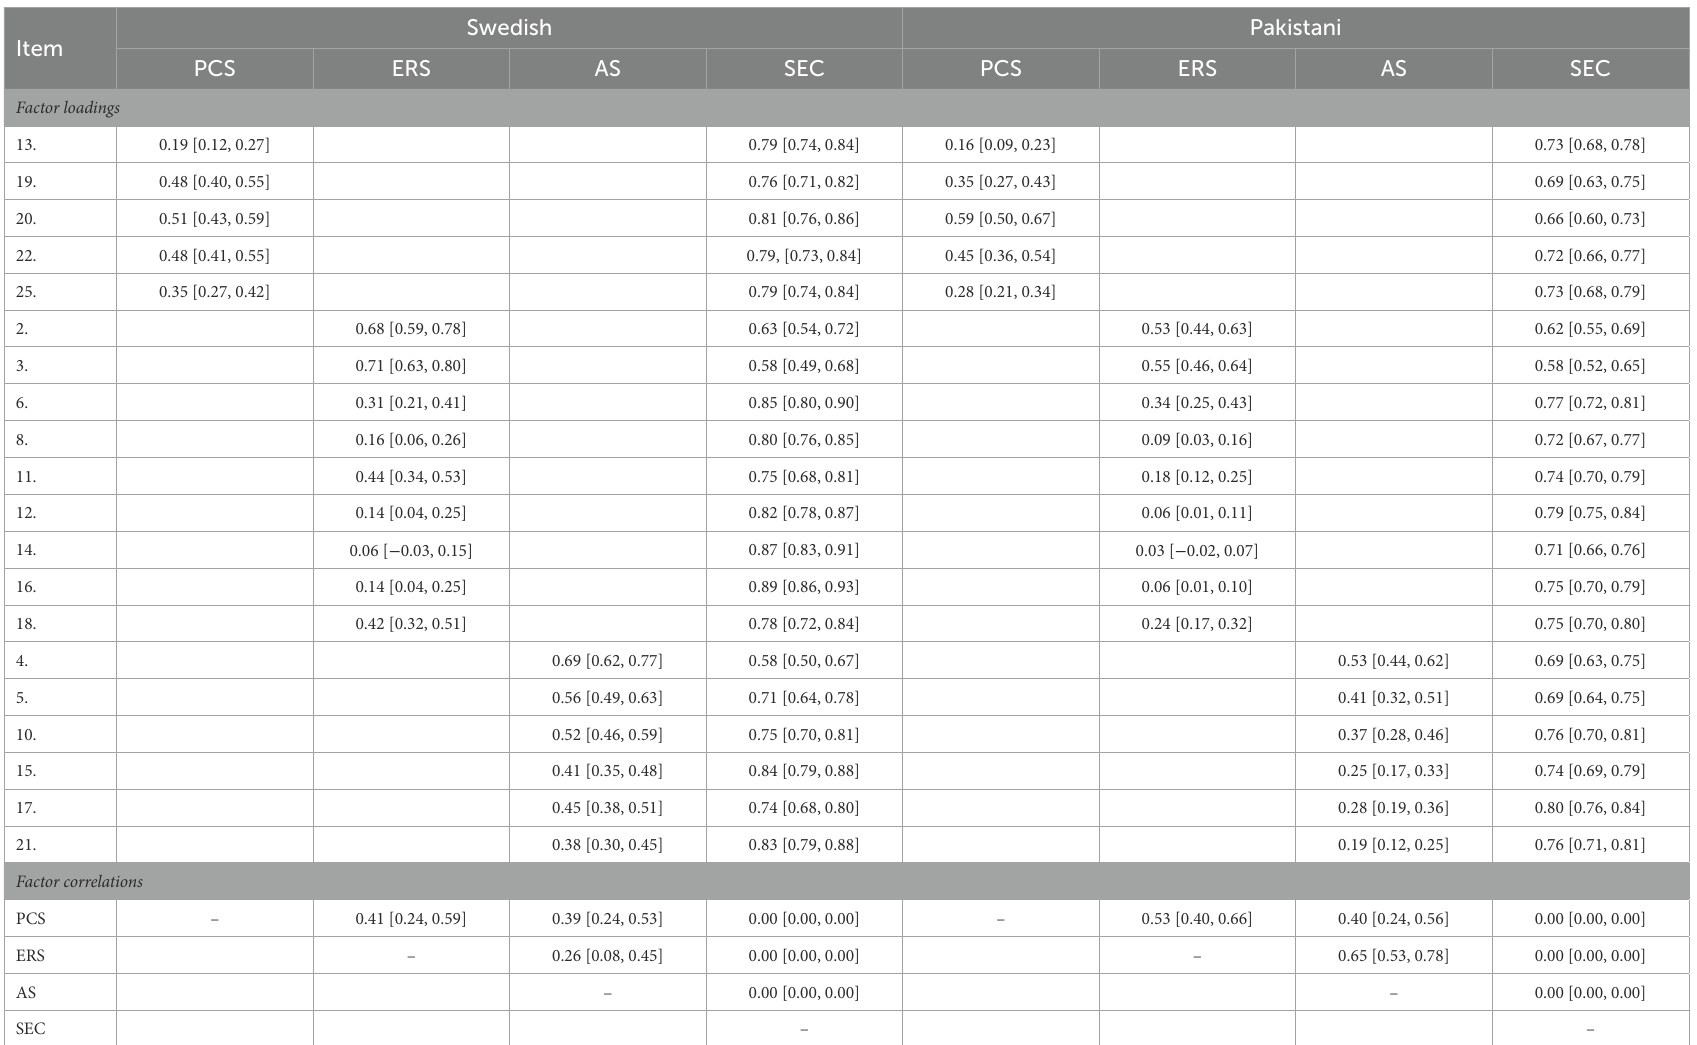
TABLE 2 Estimated factor loadings and factor